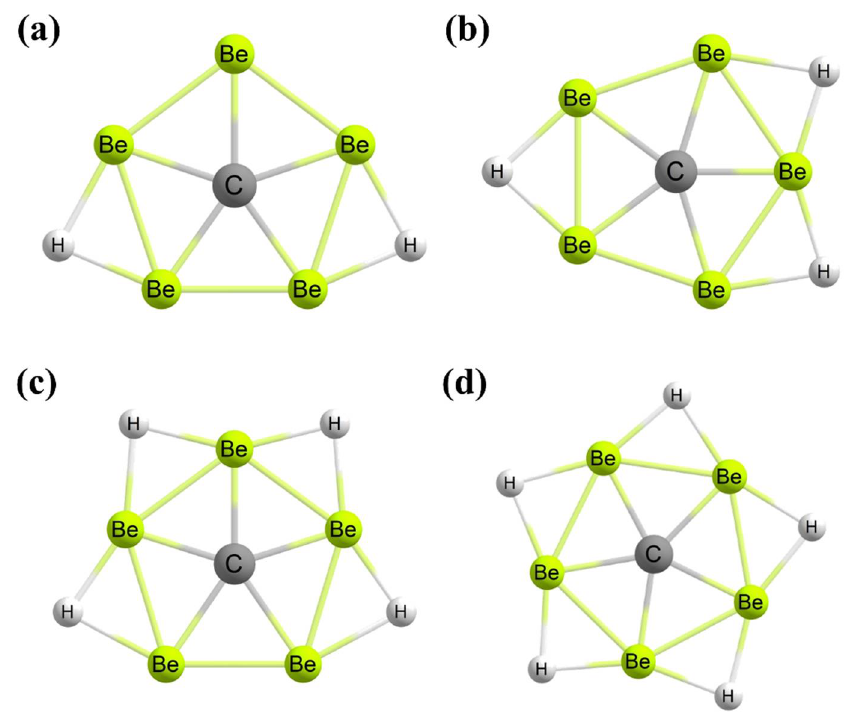
Figure 22. The global minimum structures of ( a ) CBe 5 H 22− and ( b ) CBe 5 H 3− clusters with a perfect ppC. The local and global minimum structures of ( c ) CBe 5 H 4 and ( d ) CBe 5 H 5+ clusters, respectively, with a quasi-ppC.